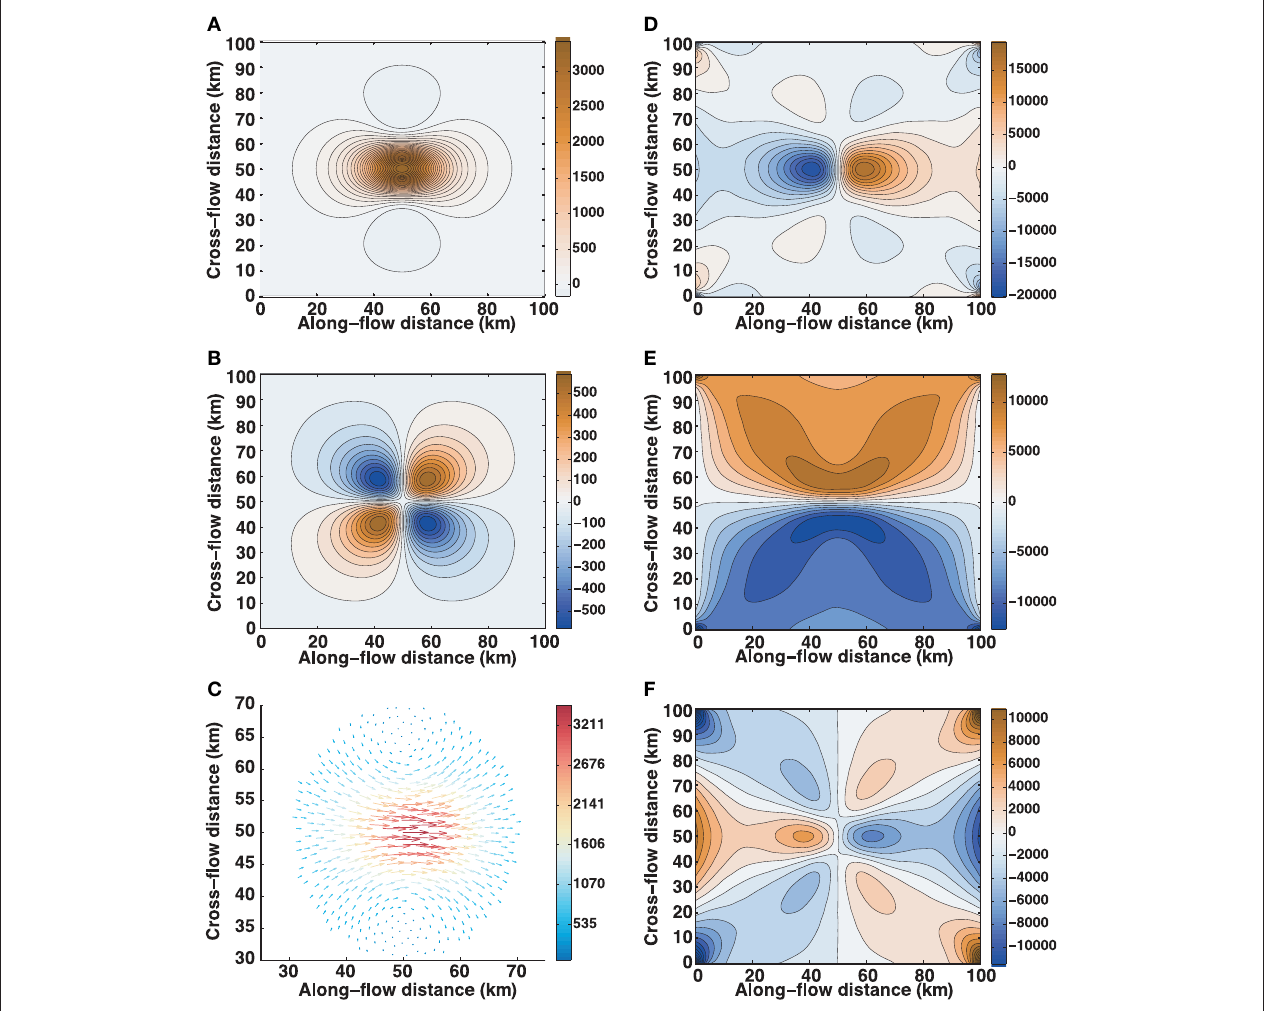
FIGURE 3 | Perturbation at t = 12 h + 5s: (A) along-flow velocity; (B) cross-flow velocity; (C) vector velocity (colored by magnitude) within 20 km of sticky-spot center; (D) along-flow stress; (E) shear stress; (F) cross-flow stress. Velocities in m a − 1 , stresses in Pa. Mean velocity is from left to right in the positive along-flow